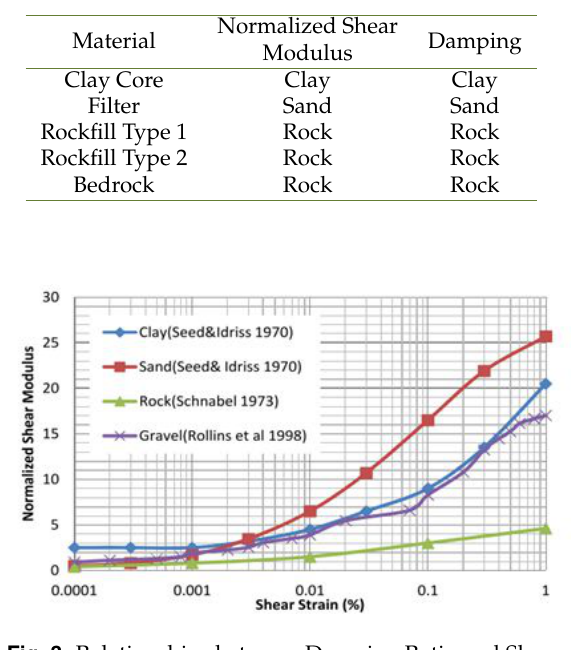
Fig. 3. Relationships between Damping Ratio and Shear Strain for Rock, Clay, and Rock used in Site Response Analysis.